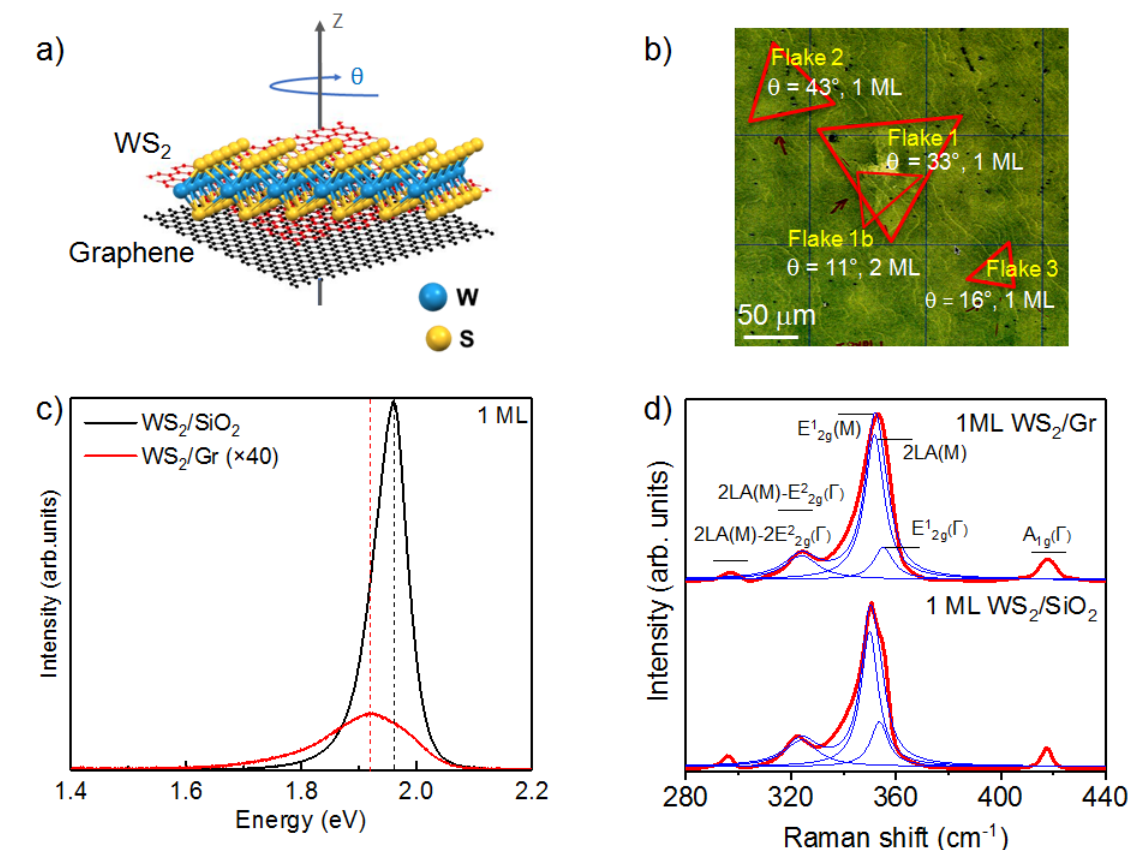
Figure 1. Structural and electronic properties of a WS 2 /Gr heterostructure: ( a ) 3D view of graphene on top of monolayer TMDs. Here, θ is the twist angle between graphene and the TMD layers; ( b ) Optical image of the WS 2 transferred onto the graphene layer; ( c , d ) Room temperature PL and micro ‐ Raman spectra of Flake 1 before (1 ML WS 2 /SiO 2 ), and after (1 ML WS 2 /Gr), transfer.